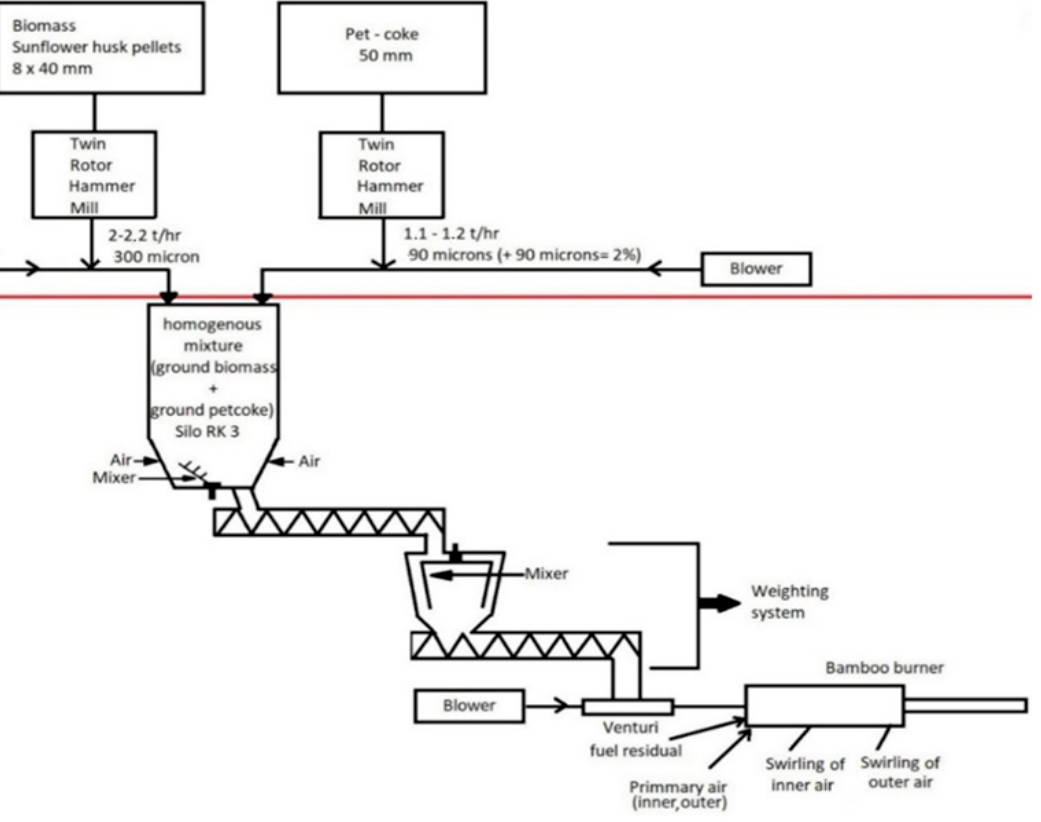
Figure 5. The new fuel mix preparation and feed system for Rotary Kiln No. 3. The part under the red line refers to the new installation.